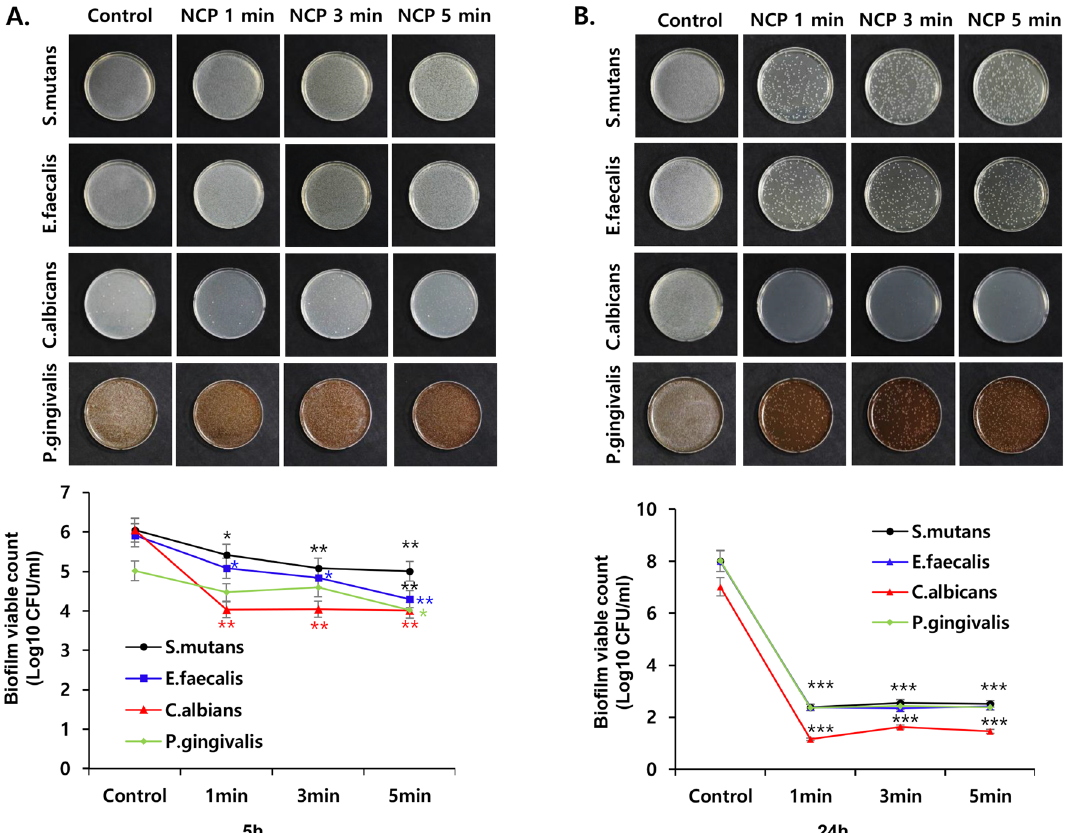
Figure 4. The bactericidal effect of NCP against 4 oral microbes in liquid medium. The results of experiments testing the sterilsation effect of NCP on S. mutans, E.faecalis, C.albicans and P.gingivalis in liquid medium. The medium containing oral microbes were subjected to 1, 3, and 5 min of NCP treatment respectively. After 5 h ( A ) and 24 h ( B ) of additional incubation in liquid medium, the samples were undergone a serial dilution, and plated on solid medium. At 24 h of further incubation, the representative photographs were taken (upper panel), and the number of colony was counted, and the results was presented as a graph (bottom panel). Data shown are the representatives of three independent experiments, *p < 0.05, **< 0.01, ***<